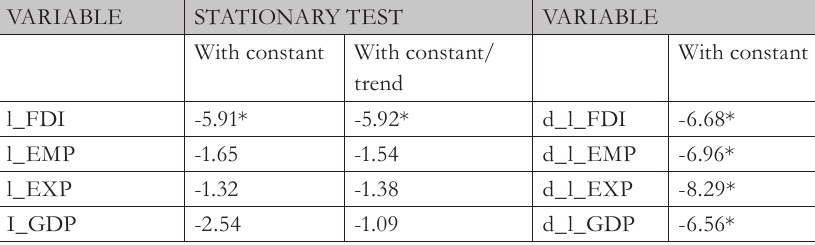
Tab. 1 – Results of the ADF test. Source: own